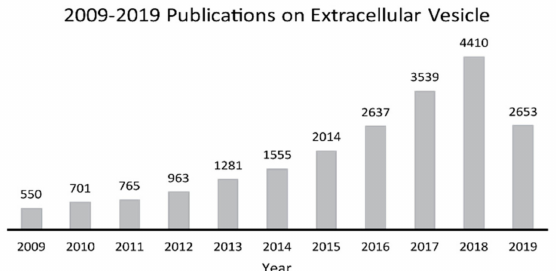
Figure 1. Publication trends on extracellular vesicle studies in the past decade (2009.1 to 2019.7). Publications were selected by searching the keyword “extracellular vesicle” in the Web of Science from the year of 2009.1 to 2019.7. x axis: year; y axis: number of